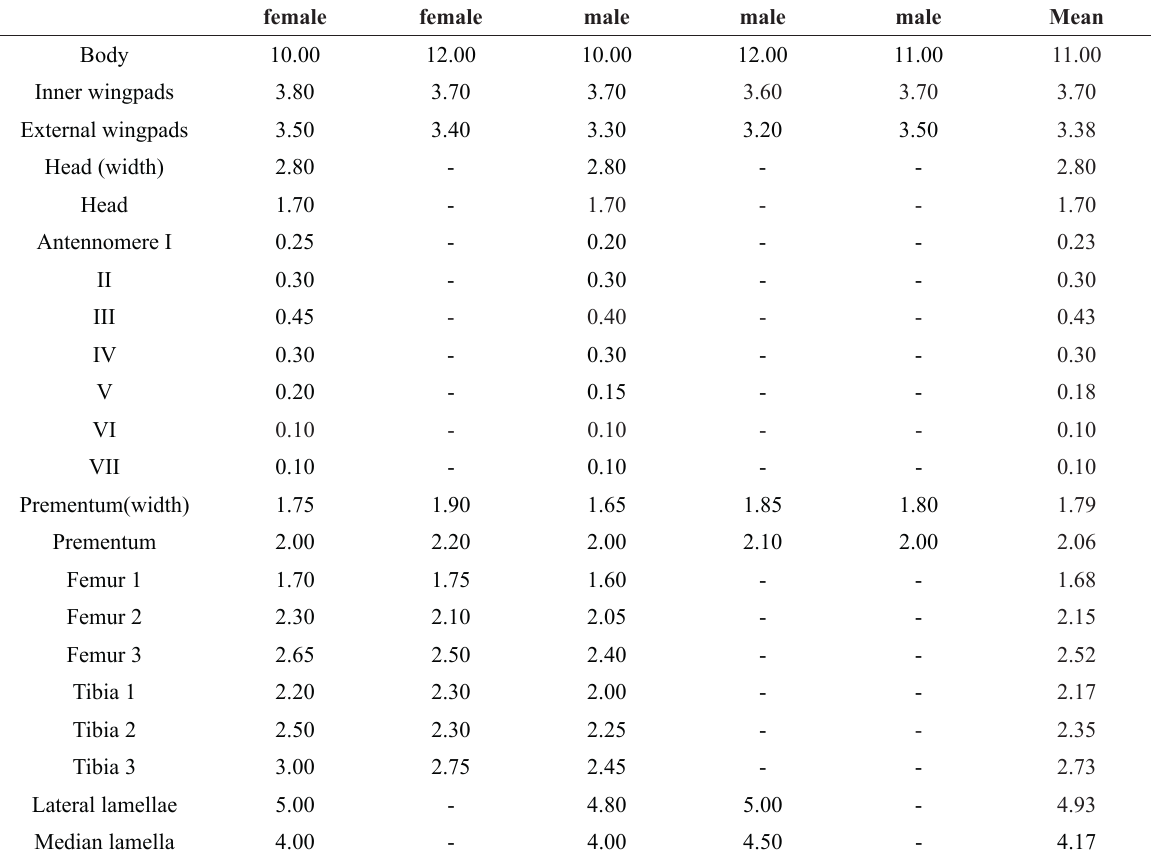
Measurements (mm) from 5 last instar larvae. Body length does not include appendages. All the measures are lengths, unless otherwise